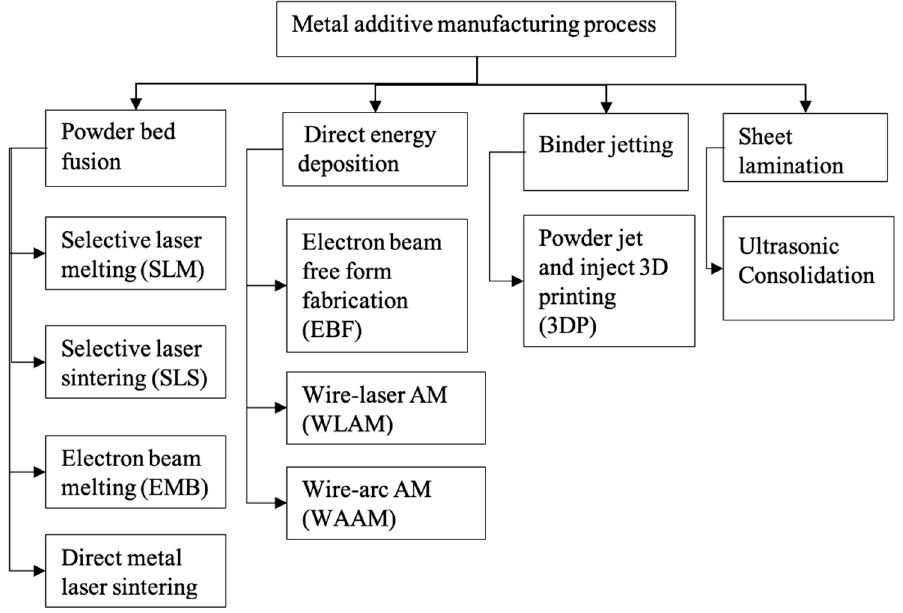
Figure 9. Metal additive manufacturing process classification [174].